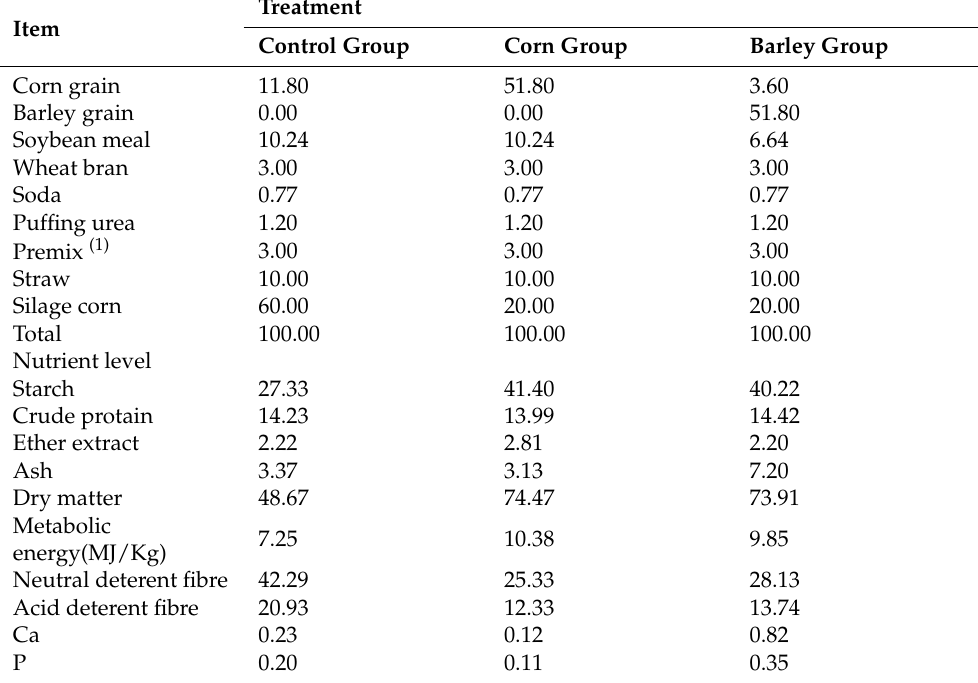
Table 2. Phase II dietary formulations and components (DM) (%).